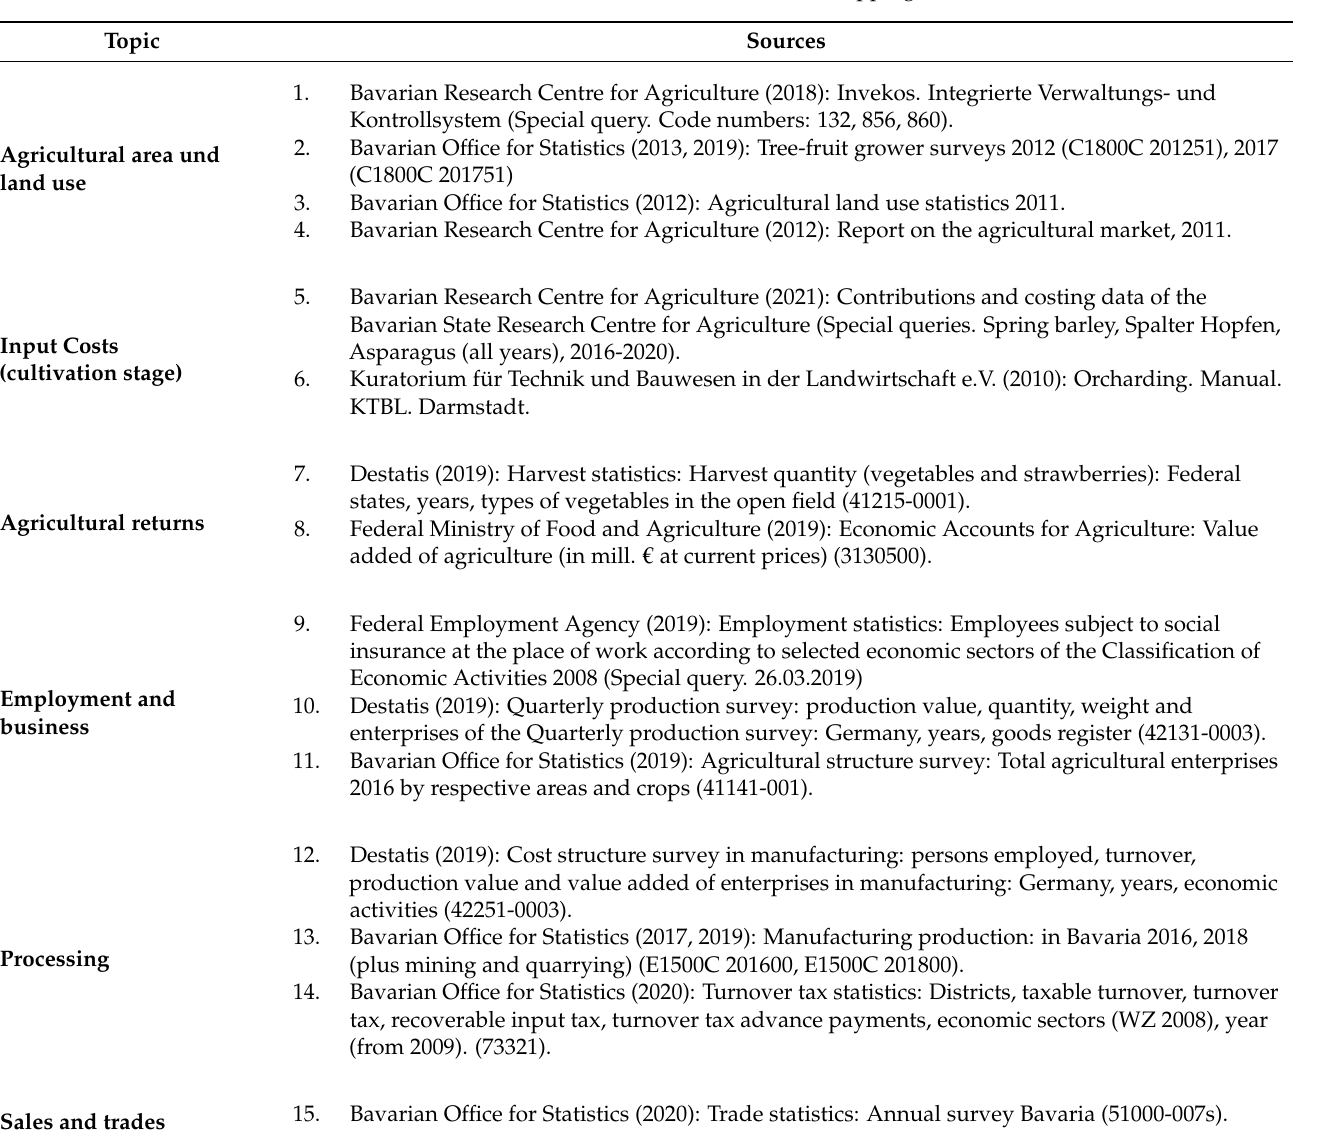
Table 1. Statistical data basis for value creation